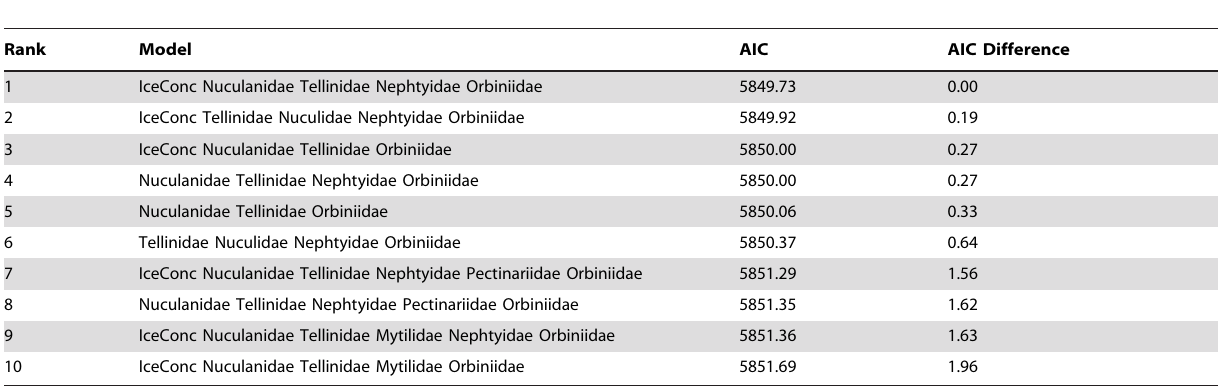
Table 4. Ten highest-ranked models among 319 models fitted to estimate Pacific walrus resource selection in the northern Bering Sea.